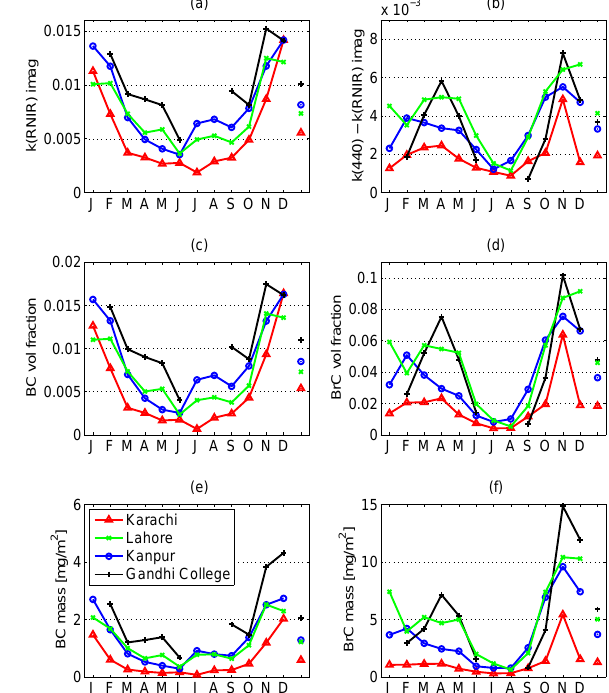
Figure 4. Monthly averages of imaginary indices and the retrieved fraction of carbonaceous aerosols: (a) average of the imaginary in- dex at 670, 870, and 1020nm ( k RNIR ); (b) difference between the imaginary index at 440nm and k RNIR ; retrieved volume fractions of (c) BC and (d) BrC; retrieved columnar concentrations in mgm − 2 of (e) BC and (f) BrC. Corresponding annual averages are given after